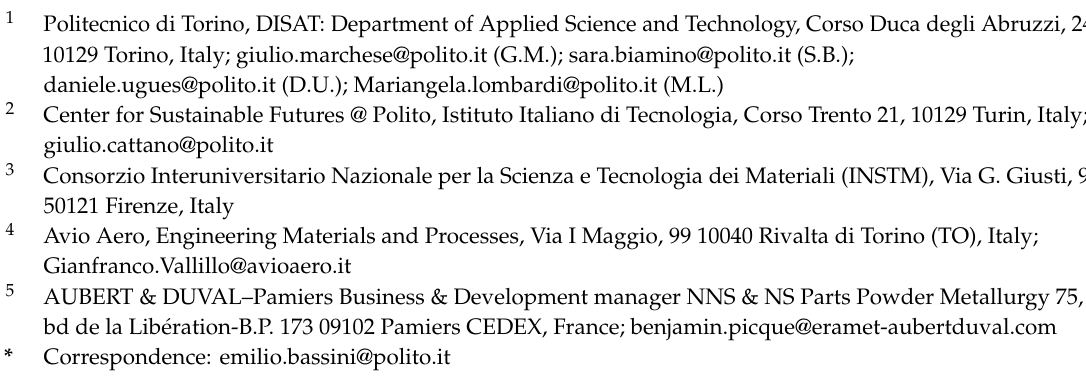
Figure 1. Astroloy in the as-HIPped (hot isostatic pressing) condition a ); after sub-solvus solutioning b ); after super-solvus solutioning c ).